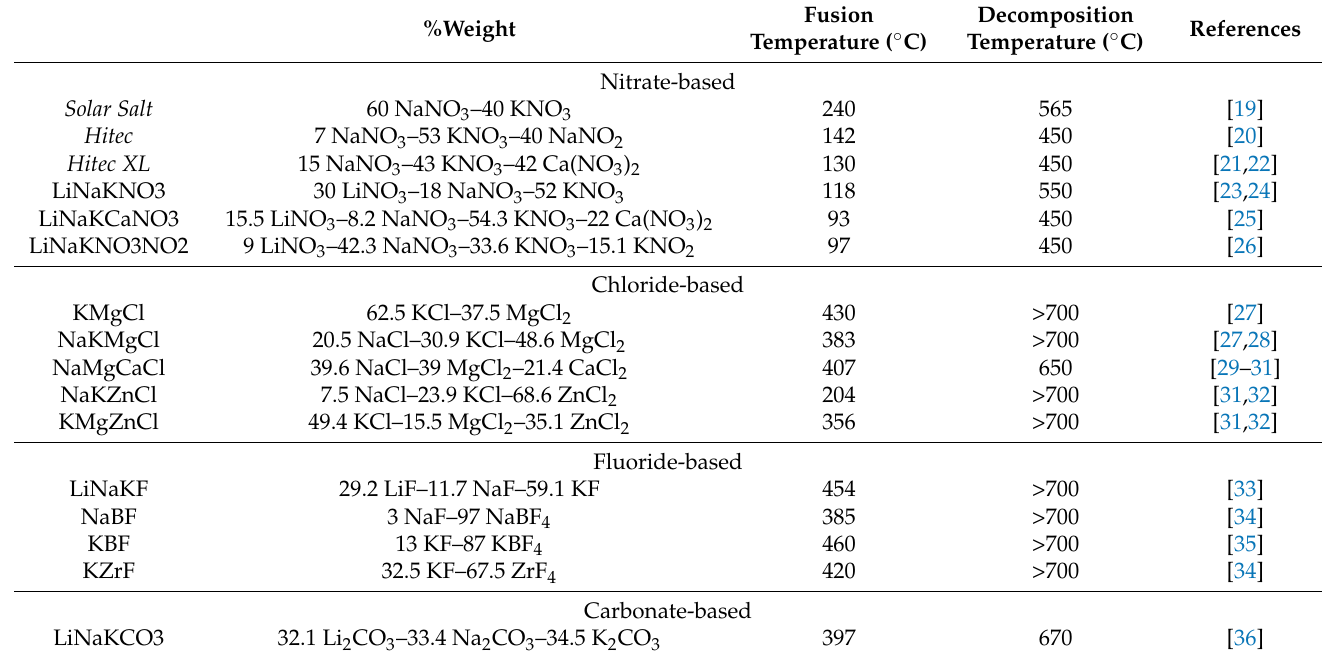
Table 1. Composition, fusion, and decomposition temperatures for selected molten salt thermal energy storage (TES) materials.